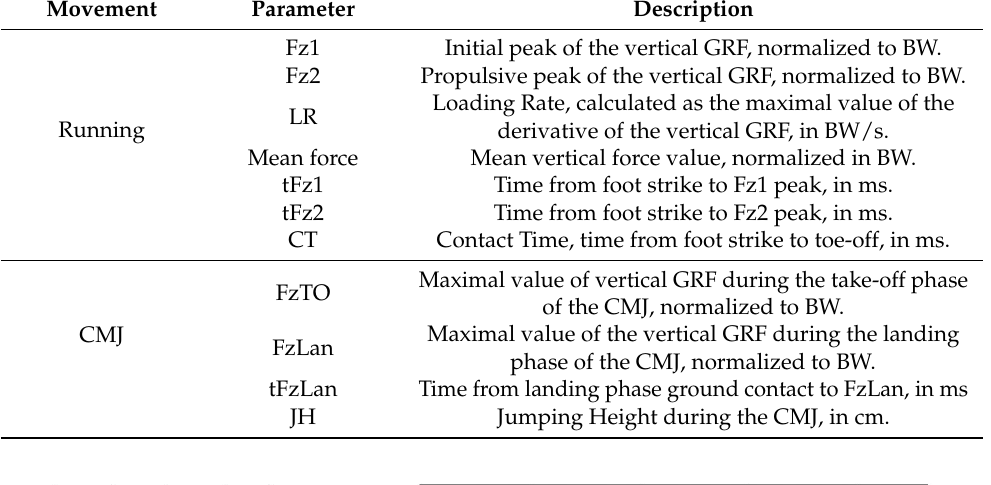
Table 1. Description of kinetic and temporal vGRF parameters computed during running and countermovement jumps (CMJs).